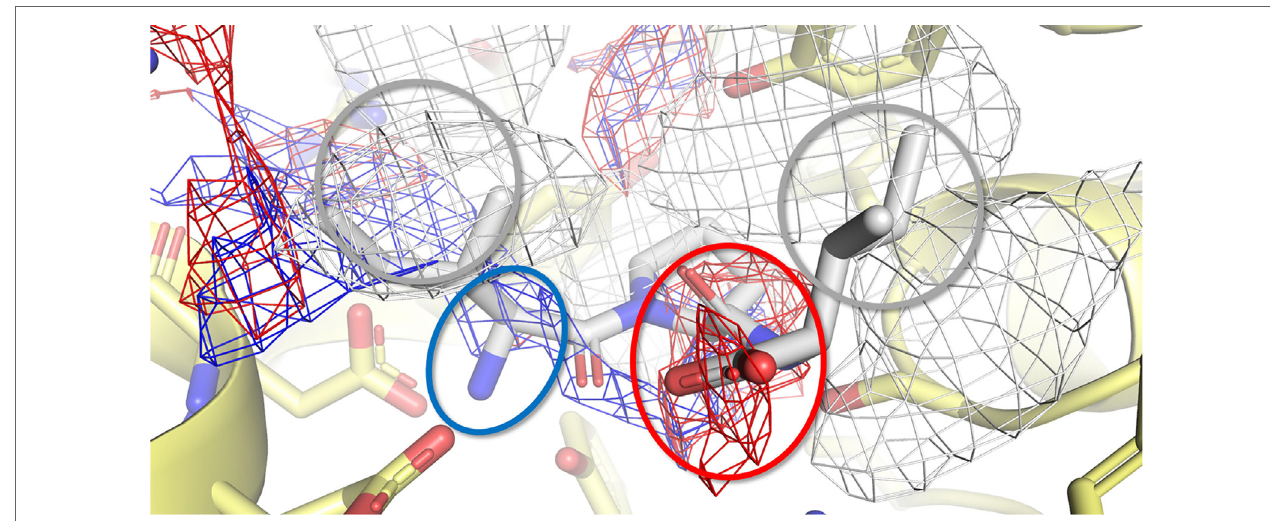
FigUre 7 | Calculated binding pose of Ile-Pro-Ile within the active site of porcine dipeptidyl peptidase IV (DPP-IV). The protein is represented in cartoon, while the amino acids constitutive of the binding site (yellow) and Ile-Pro-Ile (white) are shown in sticks. The white, blue, and red meshes identify regions sterically and energetically favorable for hydrophobic, hydrogen bond donor and hydrogen bond acceptor groups, respectively. The proper placement of the Ile-Pro-Ile groups in respect to the pharmacophoric requirements of the pocket is highlighted with rings. Specifically, gray indicates hydrophobic regions, while red and blue indicate regions suitable to receive hydrogen bond acceptor and donor groups,